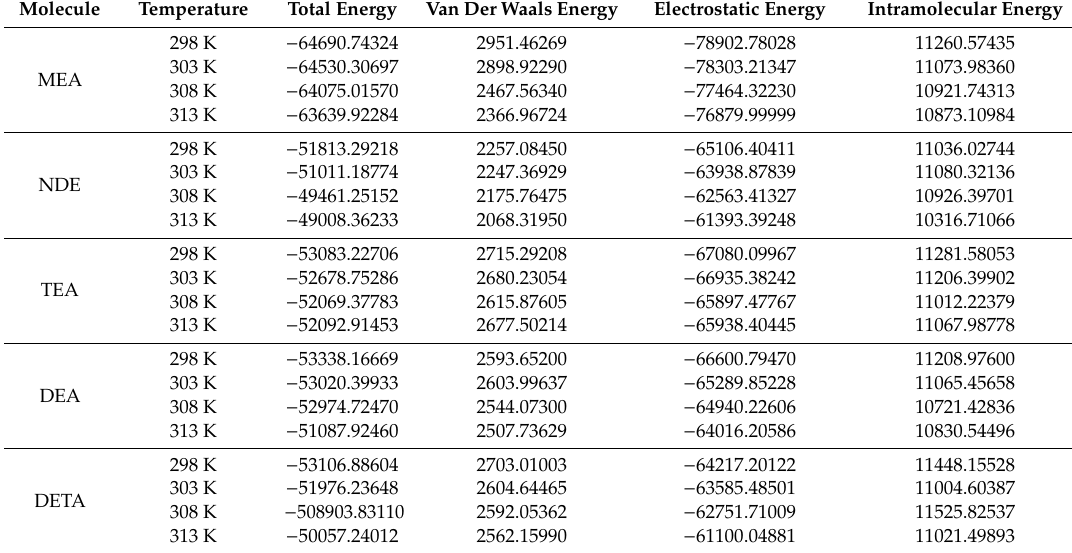
Table 4. Total energy, van der Waals energy, electrostatic energy and intramolecular energy of every system in di ff erent temperatures (kcal /